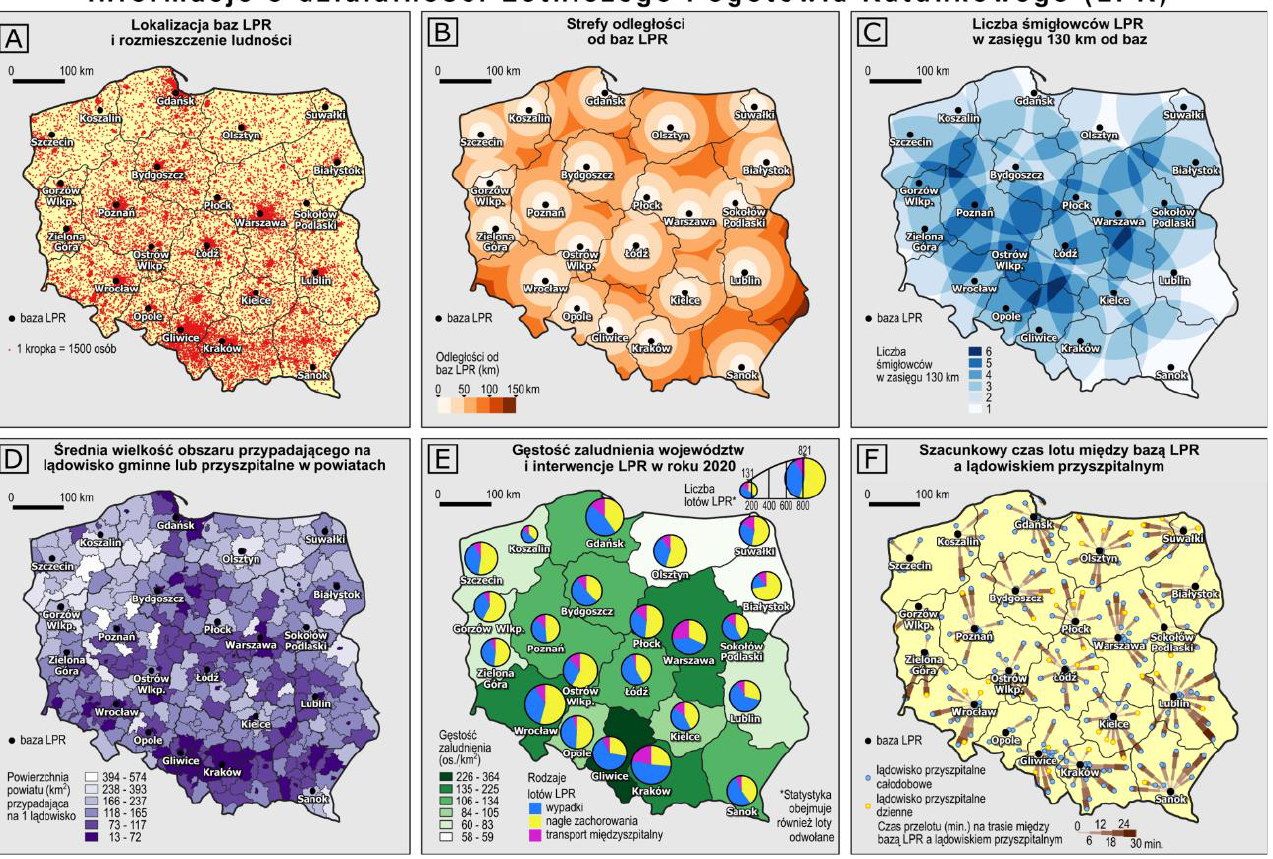
Figure 1. Six thematic maps connected with the topic of Helicopter Emergency Medical Service evaluated in the study (Polish original spelling used in the survey; for details see Figure 2). During the process of cartographic symbolization, a different color variant was selected for each map to graphically code each piece of geographical information differently